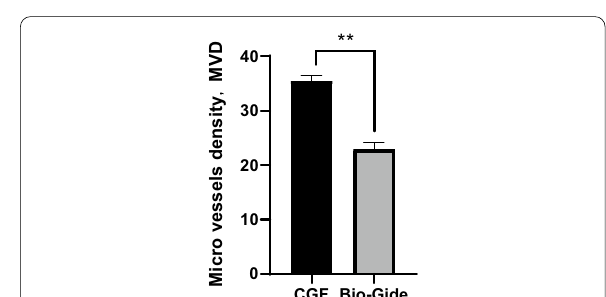
Fig. 10 Micro-vessels density (MVD) in CGF and Bio-Gide